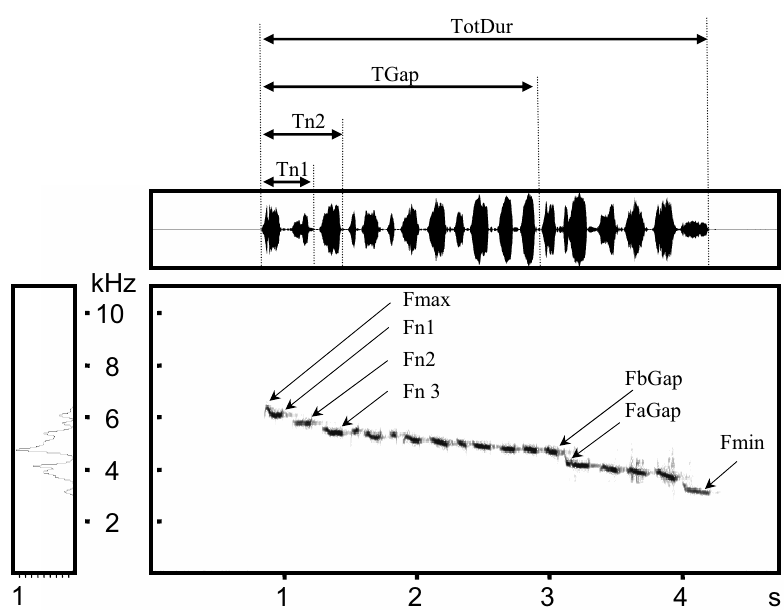
Fig. 1 – Typical territorial song of Basileuterus leucoblepharus and measures done in the temporal and frequency domains (abbreviations: see